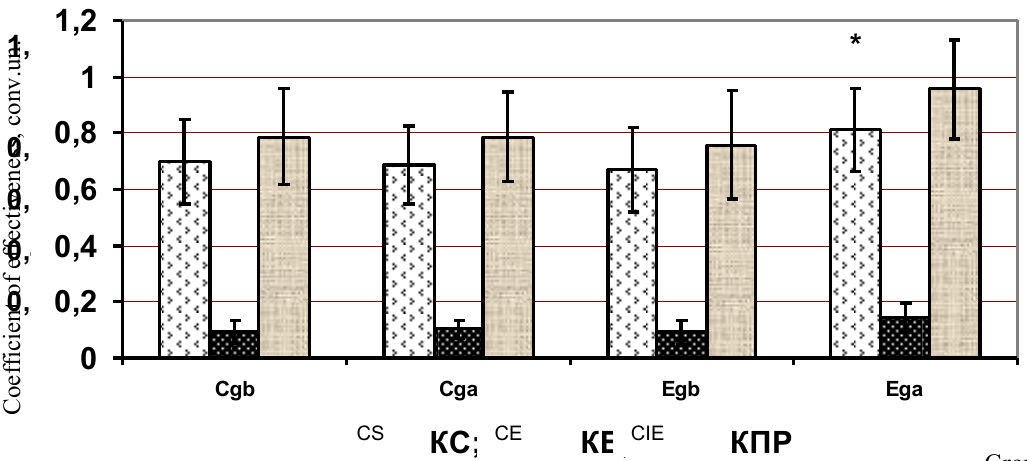
Fig.2. Integral indicators of receiving of services by 14-15 years’ old tennis players before and after experiment: Cgb – control group before experiment; Cga – control group after experiment; Egb – experimental group before experiment; Ega – experimental group after experiment* - p<0.05